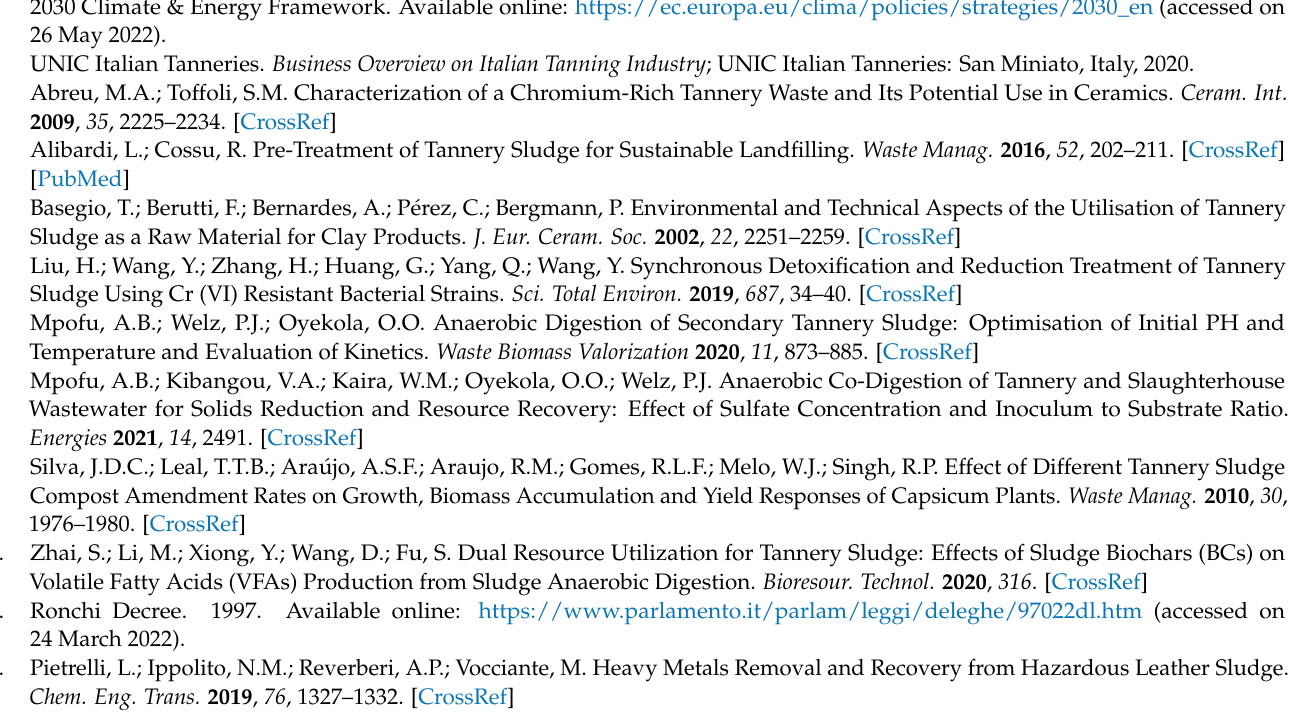
Table S2: Summary of the main results (average data) obtained in the thermophilic (T8, T12, T8-P) anaerobic fermentation of the tannery